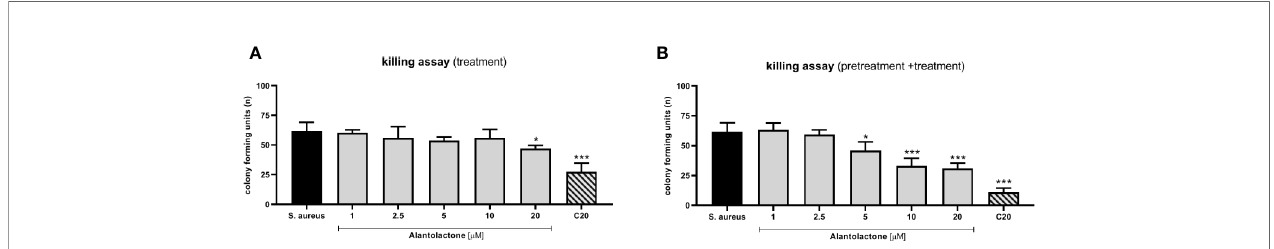
FIGURE 7 | The effect of alantolactone on S. aureus phagocytosis ef fi ciency performed by (A) THP-1 cells treated with alantolactone after infection (B) and THP-1 cells pretreated before infection and treated after infection. Statistical signi fi cance: *p < 0.05, **p < 0.01, ***p < 0.001 versus stimulated control (ANOVA and Dunnett ’ s post hoc test); S. aureus — S. aureus -stimulated control.